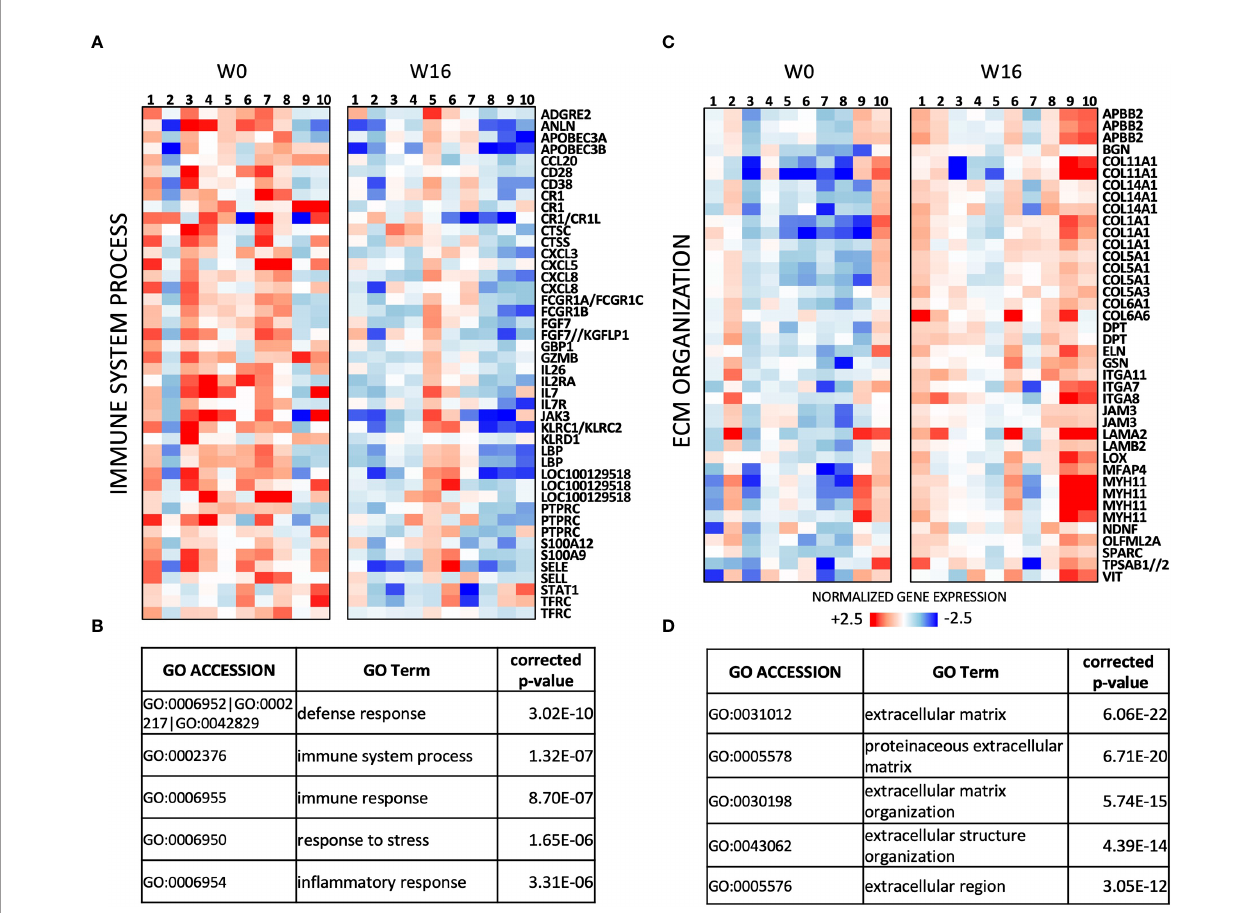
FIGURE 2 | Transcriptomic effects of abatacept in n = 10 pairs of pre/post-treatment RA synovial biopsies. (A) Heat-map of relative expression of Immune System process genes downregulated by abatacept (FC ≥ 1.5, p < 0.05, paired Mann-Whitney). (B) Top 5 Gene Ontology (GO) terms enriched in 129 transcripts downregulated between W0 and W16 (FC ≥ 1.5; p < 0.05, paired Mann-Whitney). (C) Heat-map of relative expression of extracellular matrix ( ECM) genes upregulated by abatacept (FC ≥ 1.5, p < 0.05, paired Mann-Whitney). (D) Top 5 GO terms enriched in 175 transcripts upregulated between W 0 and W 16 (FC ≥ 1.5; p < 0.05, paired